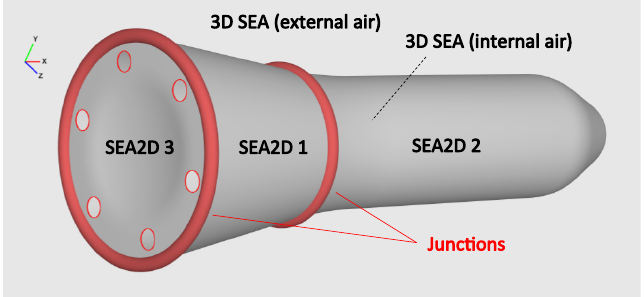
Figure 18. SEA model of the HB2 aeroshell with the surrounding air